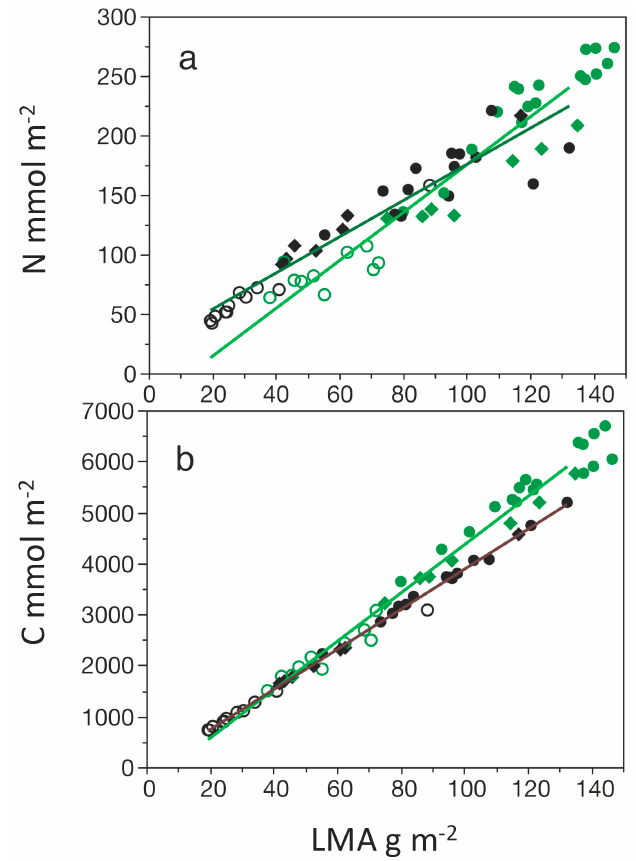
Figure 3. Variations of the relationship between leaf mass per area (LMA) and ( a ) N and ( b ) C concentrations per unit area in the vertical profile of the Castilla novel forest. Green symbols: native species; black symbols: C. elastica . Open circles (Us), squares (SC), closed circles (C). For, native species: C = − 380 + 47,000 LMA, R 2 = 0.97; and N = − 26 + 2000 LMA, R 2 = 0.92 ( n = 34). For C. elastica : C = − 53 + 39,000 LMA, R 2 = 0.99; and N = 23.4 + 1500 LMA, R 2 = 0.91 ( n = 33).